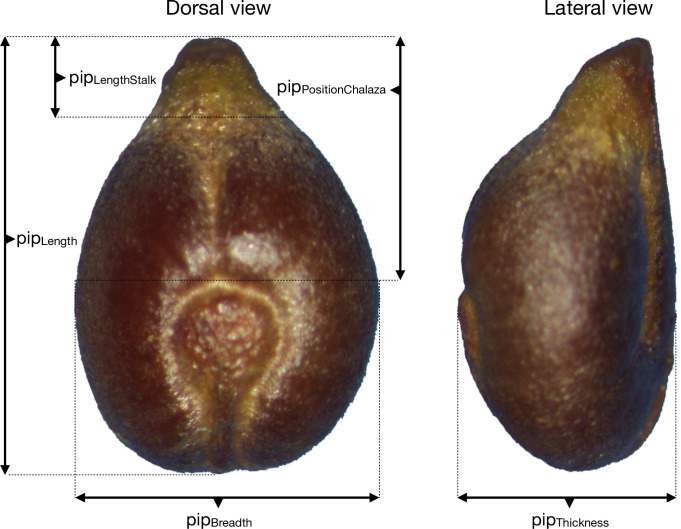
Dorsal and lateral views of a grapevine pip, here from the Vitis vinifera subsp. sylvestris wild” individual “Pic Saint-Loup 13”, with indications of morphometric measurements: piplength (total length), pipstalk (length of the stalk), pipchalaza (position of the chalaza), pipwidth and pipthickness.